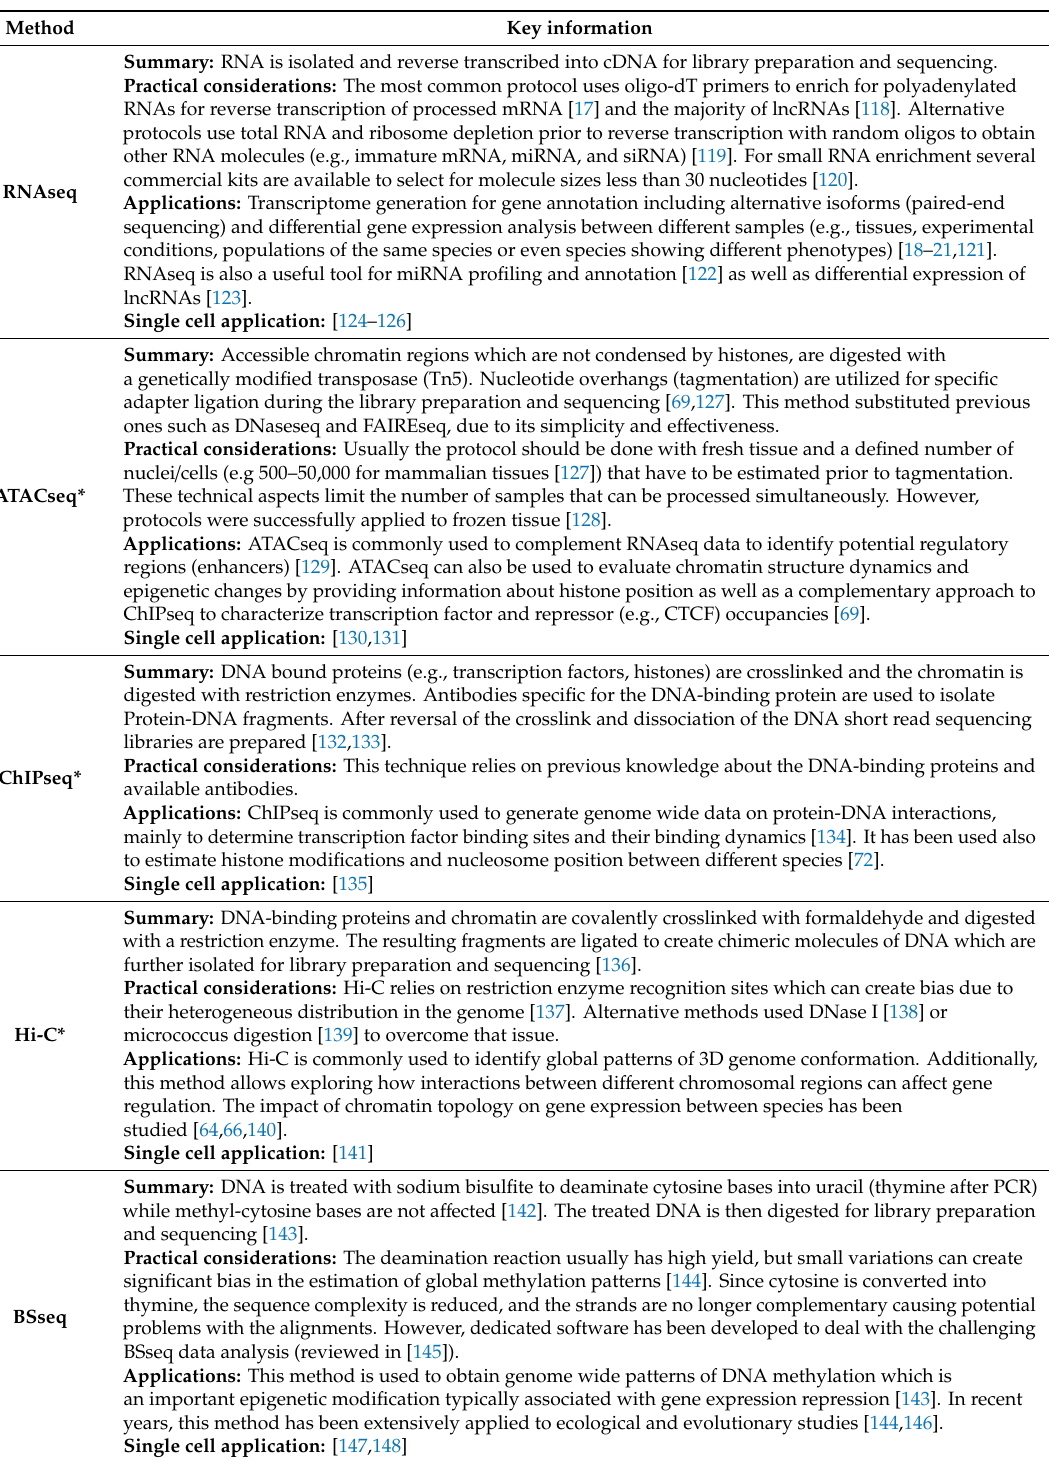
post-transcriptionally by di ff erences in generic RNA modification programs (e.g., splicing) or by the action of regulatory RNA molecules (miRNA, lncRNA). Table 1. Next generation sequencing techniques used for studying gene expression and gene regulation in evolutionary studies. Methods labelled with * require a reference